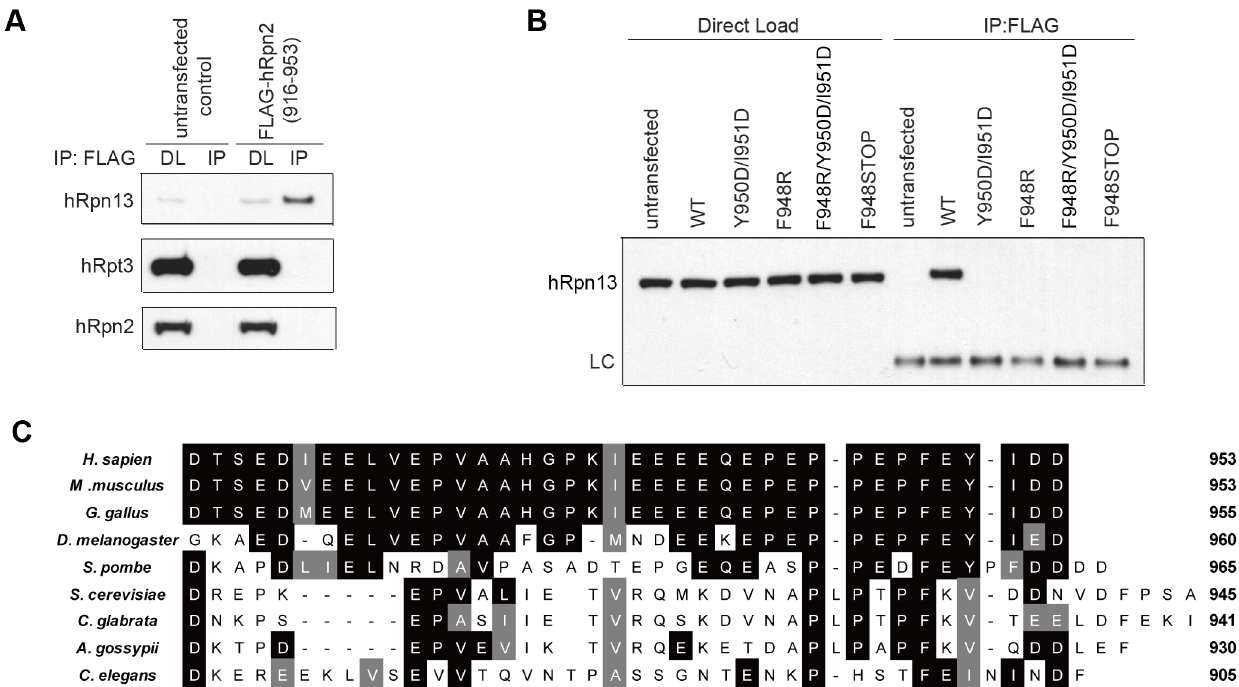
Fig 5. Strictly conserved F948 and Y950/I951 are required for hRpn2 interaction with hRpn13 in 293T cells. (A) 293T cells were transfected with or without 0.5 μ g p3XFLAG-CMV7.1-hRpn2 (916 – 953) plasmid and the cell lysates immunoprecipitated by anti-FLAG antibody and immunoprobed for proteasome subunits hRpn13, hRpt3 and hRpn2, as indicated. (B) Cell lysates or immunoprecipitates from 293T cells expressing FLAG-hRpn2 (916 – 953) wild-type (WT) or with the indicated mutations were subjected to immunoprobing with anti-Rpn13 antibody, as indicated. LC, light chain; DL, direct load. An untransfected negative control is included. (C) Alignment across species for the C-terminal 38 amino acids of Rpn2. Strictly and moderately conserved amino acids are shaded in black and grey, respectively. This Fig was generated by using ClustalW2 (http://www.ebi.ac.uk/Tools/msa/clustalw2/). doi:10.1371/journal.pone.0140518.g005 PLOS ONE | DOI:10.1371/journal.pone.0140518 October 14,